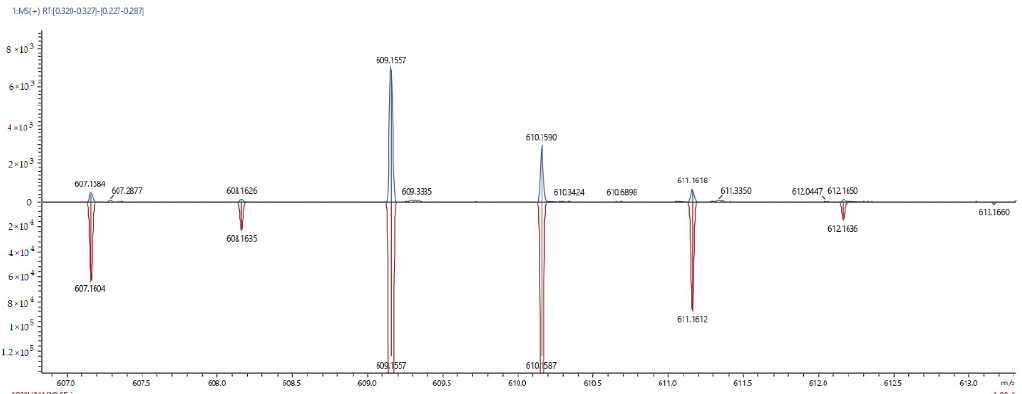
Figure 7. ESI MS of triglycine ferrocenemethanol ether.